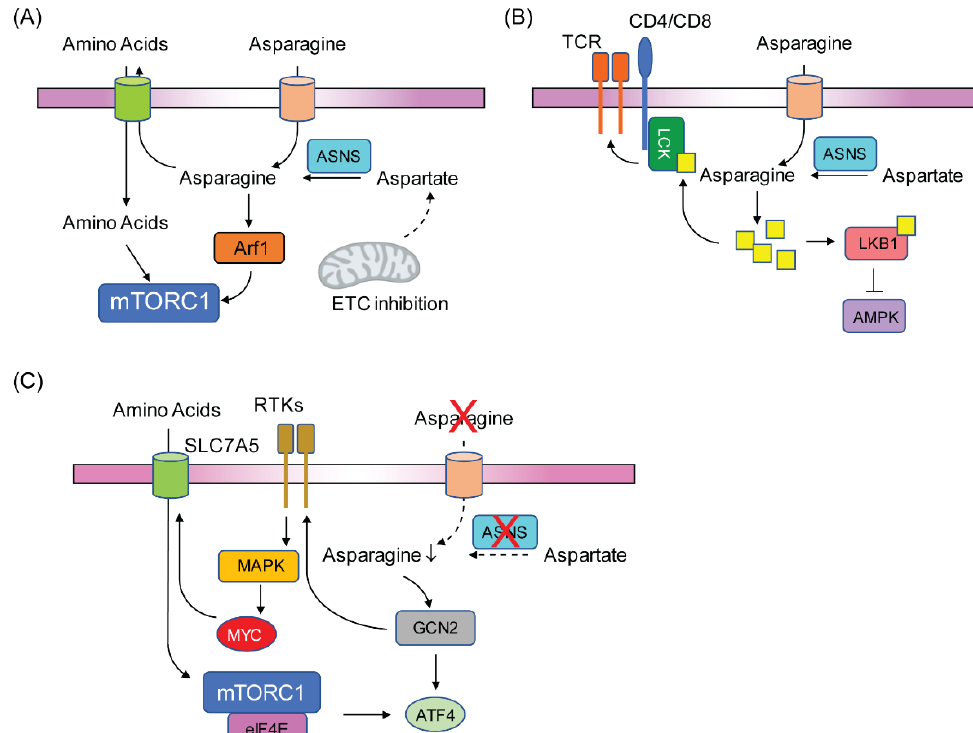
Figure 3. Signaling pathways regulated by asparagine or its depletion. ( A ) Asparagine activates mTORC1 through Arf1 or through importing other amino acids. Asparagine can also maintain mTORC1 activity during ETC inhibition. ( B ) Asparagine can directly bind to LCK or LKB1 to modulate their activities. As a result, asparagine is a positive regulator of TCR signaling and a negative regulator of AMPK pathway. ( C ) Asparagine depletion activates MAPK pathway through the induction of RTKs. MAPK activation leads to the engagement of MYC-SLC7A5 axis to support amino acid uptake, which subsequently activates mTORC1/eIF4e to support the translation of ATF4